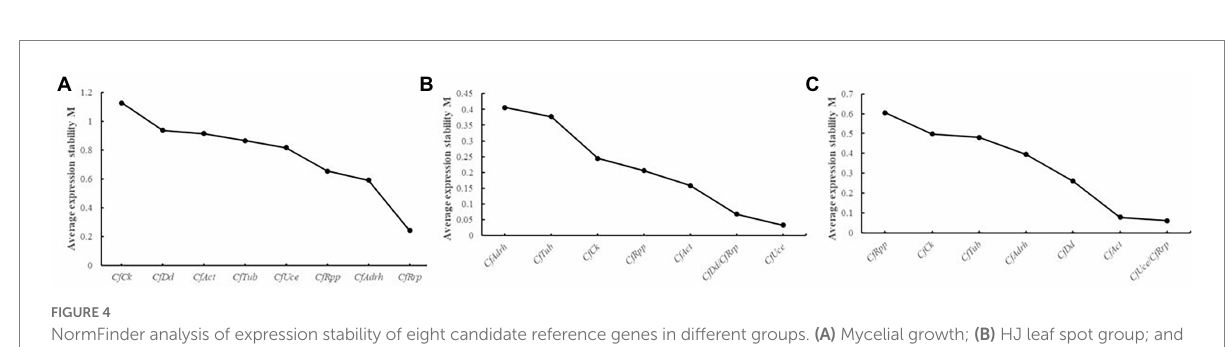
FIGURE 4 NormFinder analysis of expression stability of eight candidate reference genes in different groups. (A) Mycelial growth; (B) HJ leaf spot group; and (C) HS leaf spot group. M values represent the gene expression stability index. Higher M values indicate that the gene is more unstable and vice versa.